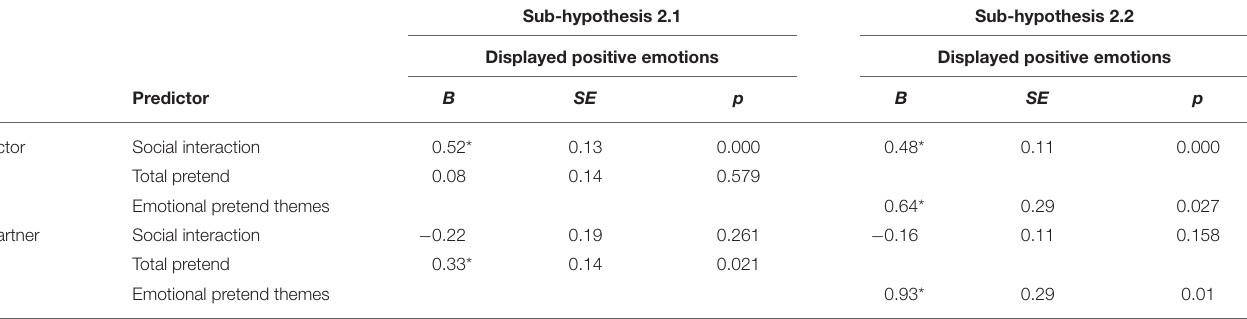
TABLE 3 | Parameter estimates for two actor-partner interdependence models ( N = 54